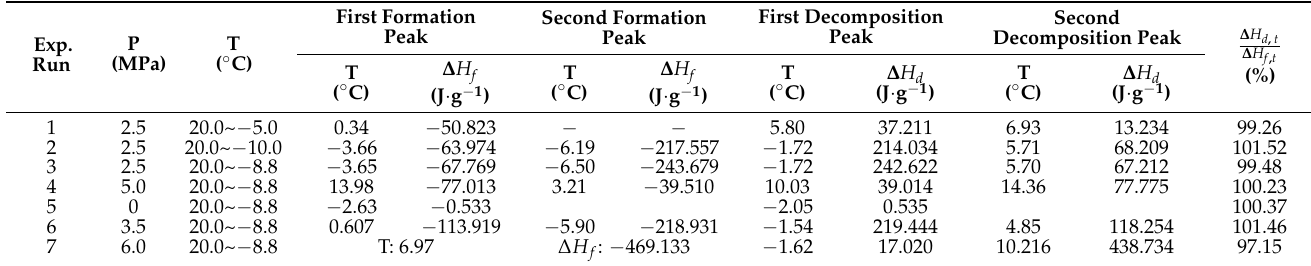
Exp. Table 2. The heat flow and temperature of the peaks corresponding to hydrate formation and dissociation under different experimental runs.